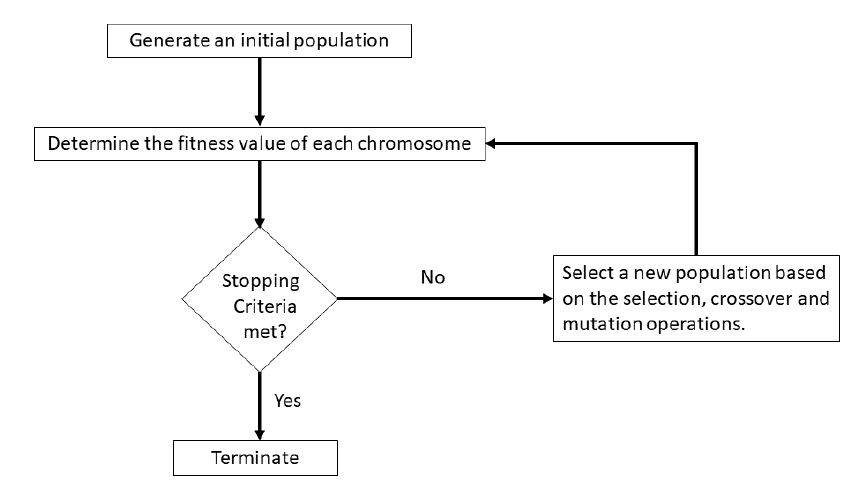
Figure 1. Flowchart of genetic